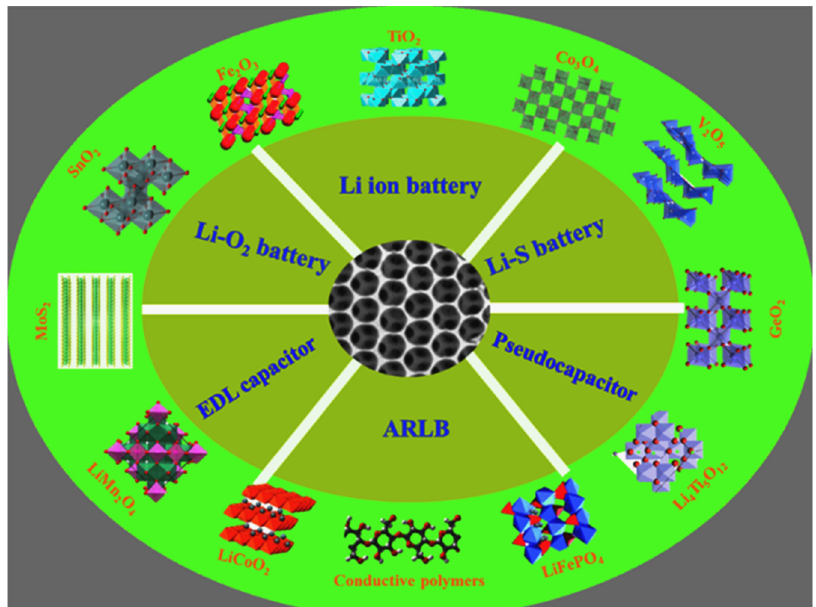
Figure 4. Different types of porous materials used in energy storage applications [16]. Reproduced with permission.